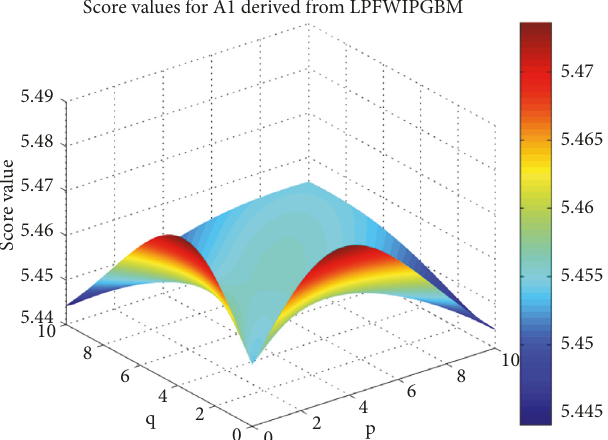
Figure 6: Score values of alternative A1 derived from LPFWIPGBM when 𝑝, 𝑞 ∈ (0, 10)